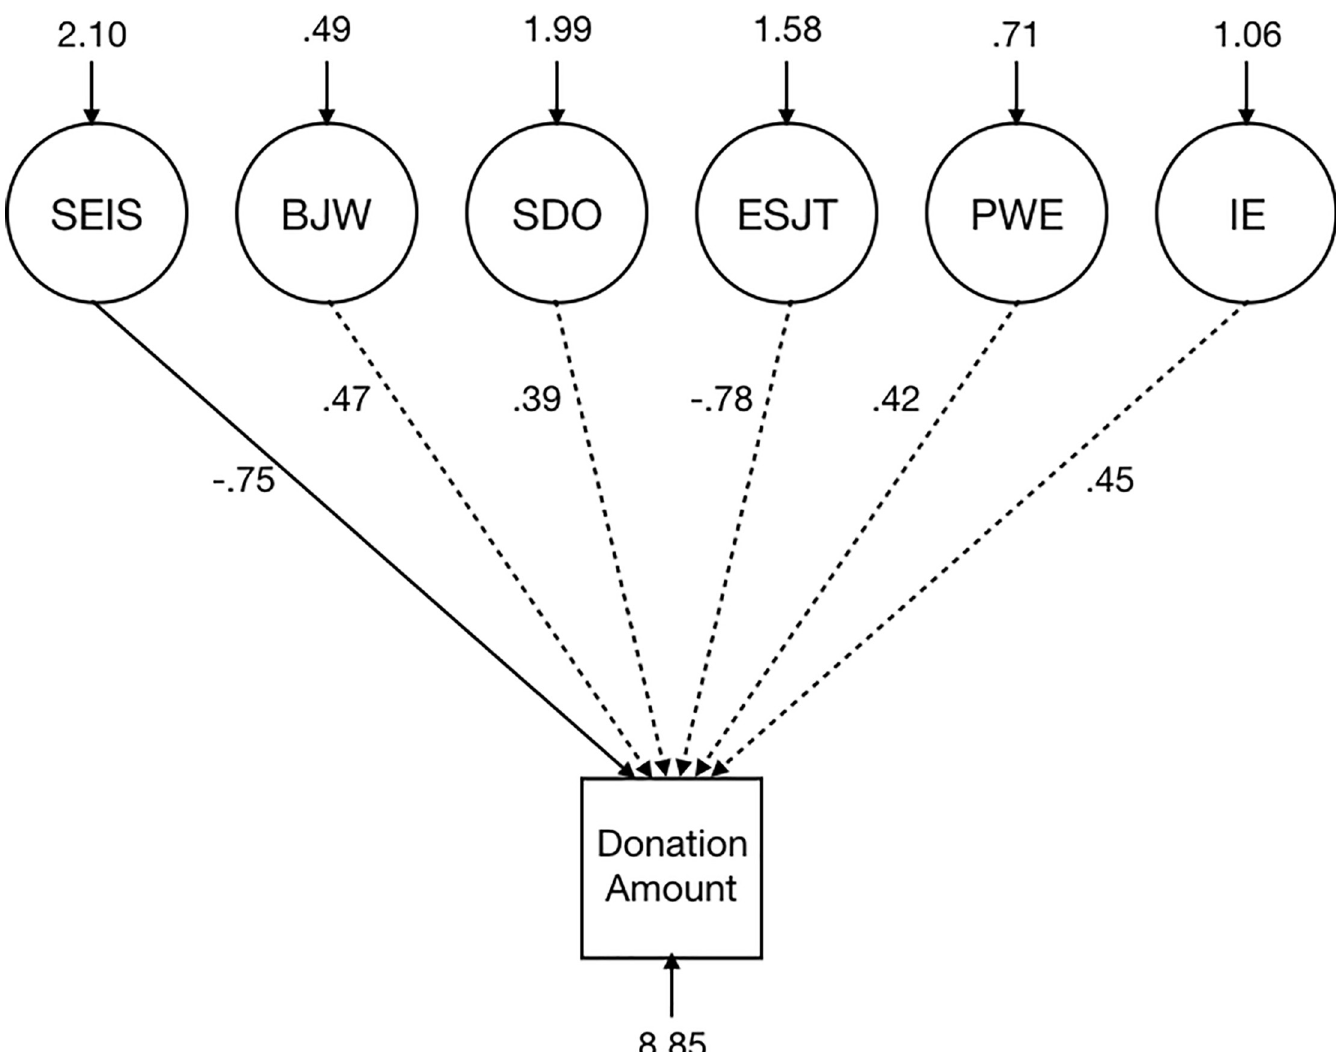
Fig 4. Analysis of separability of constructs in Study 5. A structural equation model demonstrating that the SEIS was the only significant predictor of donation amount across six conceptually similar measures.